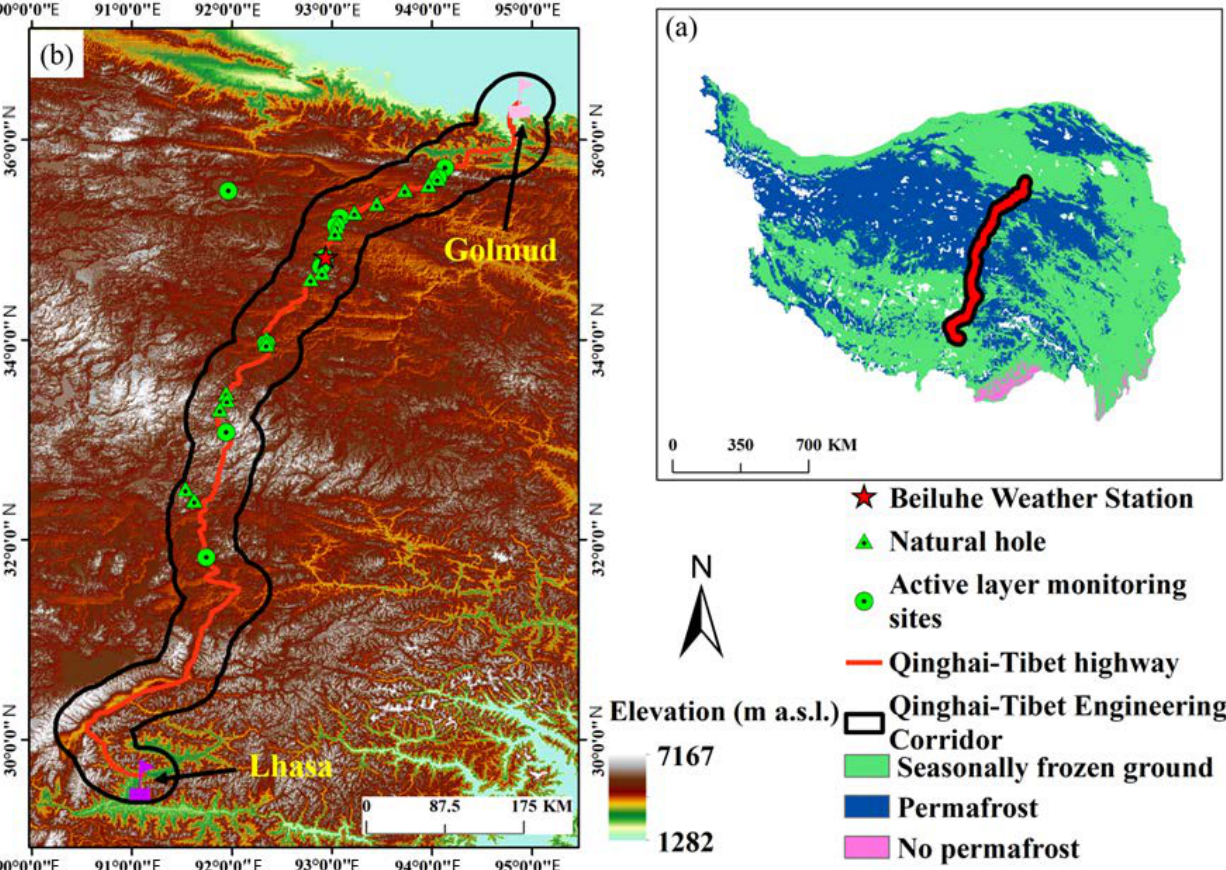
Figure 1. Study area map: ( a ) map of permafrost on the Qinghai-Tibet Plateau cited from the permafrost map by Zou et al. [16]; ( b ) elevation map of Qinghai-Tibet Engineering Corridor based on 90 m DEM